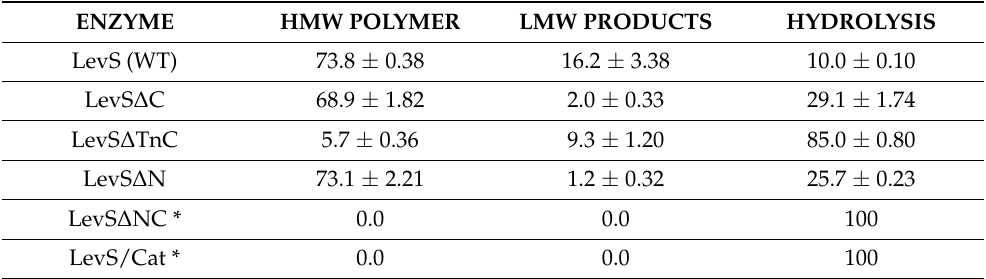
Figure 5. Oligosaccharide profile synthesized by LevS and truncated versions measured by HPAED- PAD. Reaction conditions: 1.0 U/mL enzyme, 292 mM sucrose, 30 °C, and pH 6. Reactions were analyzed at a sucrose conversion over 90%, except LevSΔNC and LevS/Cat , which reached 20%. Structures included are 1-kestose (1), 6-kestose (2), levanbiose (3), neo-kestose (4), 1,6-nystose (5), 6,6-nystose (6), levantriose (7), 1,6,6-kestopentaose (8), 6,6,6-kestopentaose (9), 1,6,6,6-kestohexaose (10), 6,6,6,6-kestohexaose (11), 1,6,6,6,6-kestoheptaose (12), 6,6,6,6,6-kestoheptaose (13), 1,6,6,6,6,6- kestooctaose (14), and 6,6,6,6,6,6-kestooctaose (15). Table 3. Percentage of fructose used for HMW polymer synthesis, LMW products synthesis, and